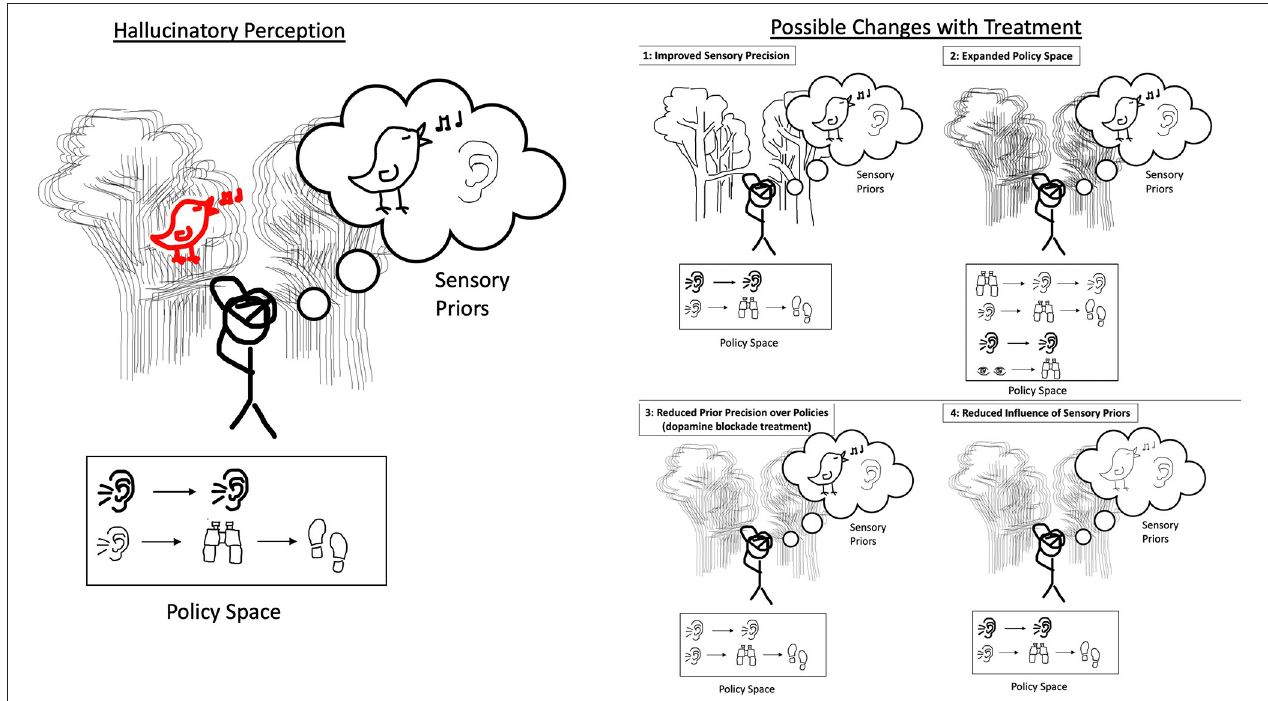
FIGURE 4 | On the left, the agent experiences degraded precision of incoming sensory evidence, a strong prior belief, a decreased policy space, and strong confidence in policy that relies exclusively on listening. This agent hallucinates the songbird as it would in the cases presented in Figures 1 – 3 . On the right are four panels, each with a single change from the hallucinatory perception on the left. Each change represents an effect that treatment could have on a hallucinating agent (note that in almost all cases multiple parameters change with treatment, but for simplicity we demonstrate the possible changes independently). The first is improved sensory precision: with clearer incoming sensory evidence, the agent can use its perception of the environment to correct for an over-weighted prior/policy or a maladapted policy space. We hypothesize that the approach of CSCs and ACT teams may help to increase the quality of and confidence in the external environment and as such improve the sensory precision. The second is expanded policy space: with additional actions that the agent could take, it can make further observations about its environment and potentially choose a policy that less heavily implies the presence of the songbird, allowing it to correct for an over-weighted prior/policy and degraded sensory information. We hypothesize that this could occur as a result of cognitive training or therapy and social interactions and external support provided through ACT teams, or that policy space could be preserved via the early intervention provided by CSCs. The third is reduced prior precision over policies: the agent now has equal confidence in the listening action as well as the listening, looking closely, and walking closer action, and as such a weaker prior favoring the presence of the bird. This is the effect hypothesized to be produced by dopamine blockade and helps the agent disengage. The fourth is reduced influence of sensory priors: when the prior beliefs are weighted equally, the agent is not biased toward perceiving the songbird despite the limited policy space and strong prior precision over policies. We hypothesize that this could occur as a result of cognitive training or therapy and social interactions and external support provided through ACT teams, or that the formation of fixed maladaptive priors could be prevented via the early intervention provided by